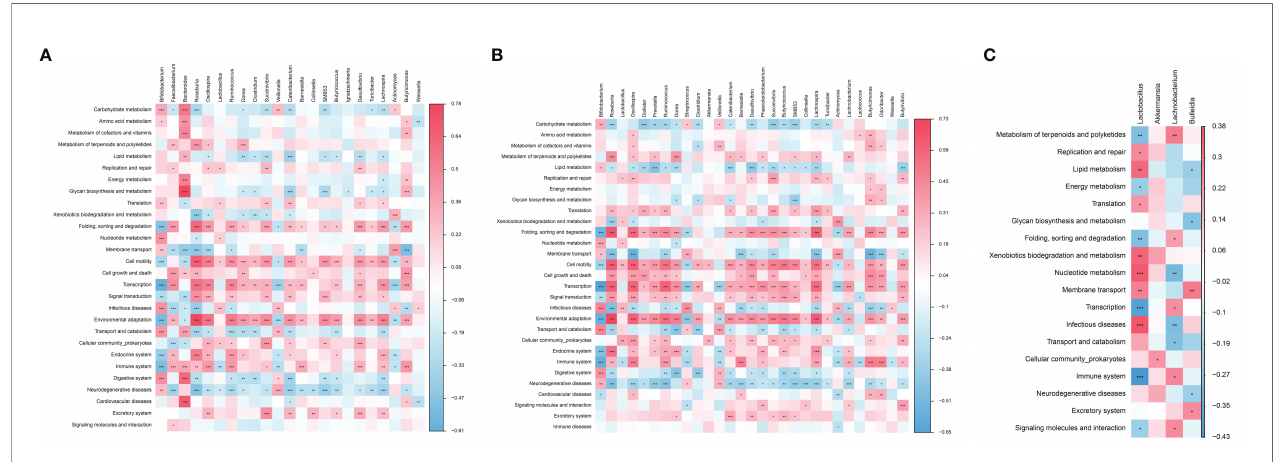
FIGURE 5 | Correlation analysis between predictive metabolic pathways and different gut microbiota. The signi fi cant correlation (A) in PTB and HC groups; (B) in PTB and LTBI groups; (C) in LTBI and HC groups. The depth of the color in the heat maps signi fi es the strength of the correlation: red represents a positive correlation, whereas blue indicates a negative correlation. *P < 0.05, **P < 0.01, ***P <